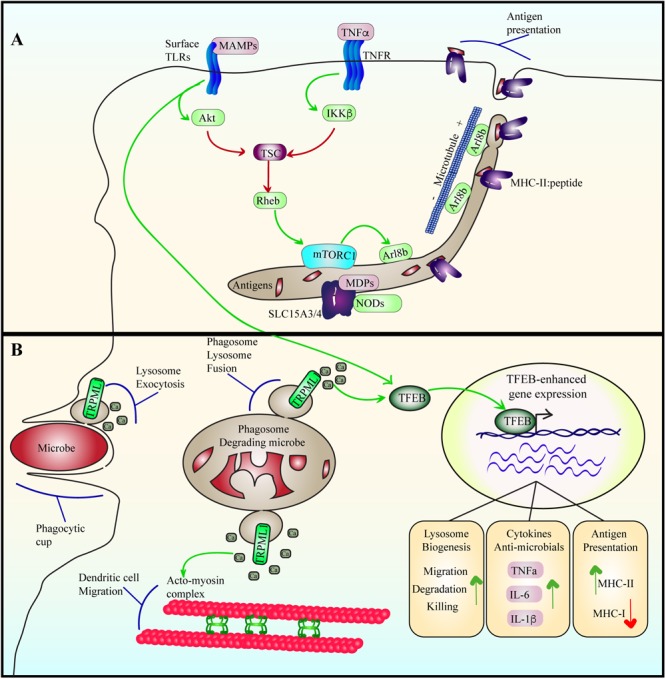
Lysosome adaptation and remodeling during immune responses. (A) Cytokine and TLR signaling stimulate mTORC1, likely by suppressing TSC using Akt and IKKβ. Among other functions, LPS-TLR4 activation of mTORC1 may stimulate the levels of Arl8b on lysosomes, which coordinates with kinesin-1 to drive lysosome tubulation and extension towards the cell periphery. This may then aid in antigen presentation in dendritic cells. Tubulation may also aid in increasing the surface area-to-volume ratio of lysosomes to favor antigen processing and export or other functions. For example, the SLC15A3/4 transporters export muramyl dipeptides originating from gram-positive bacteria to induce NOD signaling. (B) During phagocytosis, microbes are engulfed and sequestered into phagosomes. Engulfment is aided by lysosome exocytosis triggered by release of lysosomal Ca2+ via TRPML1. Phagosomes then mature by fusing with lysosomes to digest the particle. Phagosome-lysosome fusion is catalyzed by TRPML1-mediated Ca2+ release from lysosomes as well. TFEB is activated by LPS-TLR4 signaling in a delayed fashion or by phagocytosis of bacteria. During phagosome maturation, TRPML1-mediated Ca2+ elicits nuclear entry of TFEB to upregulate lysosome gene expression, enhancing the degradative and killing capacity of macrophages. In dendritic cells, TFEB activation enhances TRPML1 expression, which aids in intralysosomal Ca2+ release that coordinates the acto-myosin machinery to facilitate dendritic cell migration.